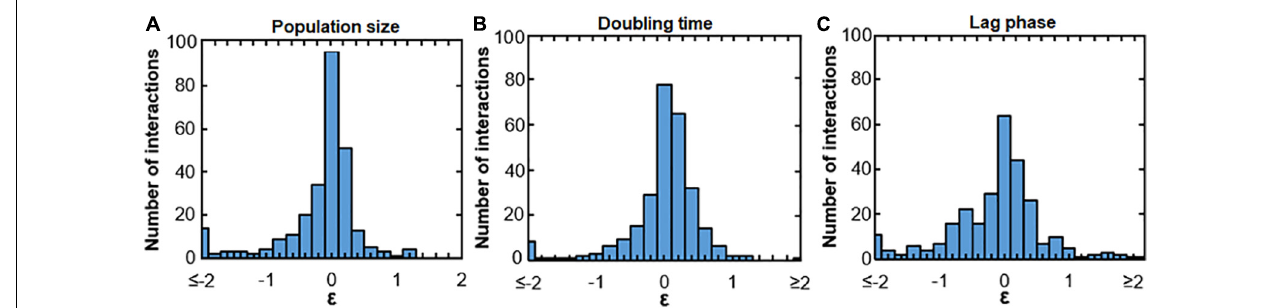
FIGURE 1 | Bacterial interactions of all measured uropathogens and commensals. Histograms show the response of uropathogens and commensals to conditioned medium. Many neutral interactions were observed (value on x -axis around 0), Values of ε < log(0.125) = –2 or ε > log(8) = 2 are binned at –2 and 2, respectively. (A) Growth interactions affecting population size. Values of ε > log(1) = 0 indicatea larger population size in comparison to the unconditioned reference medium and values of ε < log(1) = 0 indicate a smaller population size. (B) Growth interactions affecting the growth rate. Values of ε > log(1) = 0 show an increased maximum growth rate in comparison to the reference medium and ε < log(1) = 0 show a decreased growth rate. (C) Growth interactions affecting the length of the lag phase. A value of ε > log(1) = 0 indicates a shorter lag phase and ε < log(1) = 0 indicates a longer lag phase in comparison to growth in the reference